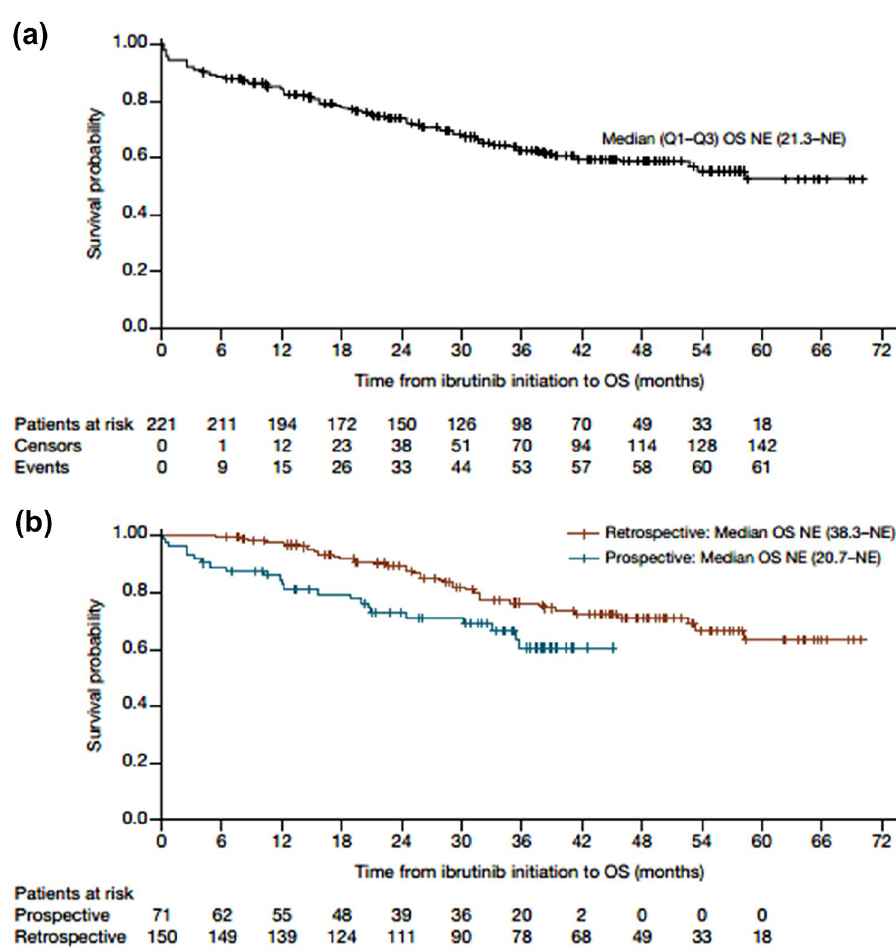
Fig. 2 a OS for total population corrected with left truncation. b OS for prospective and retro- spective